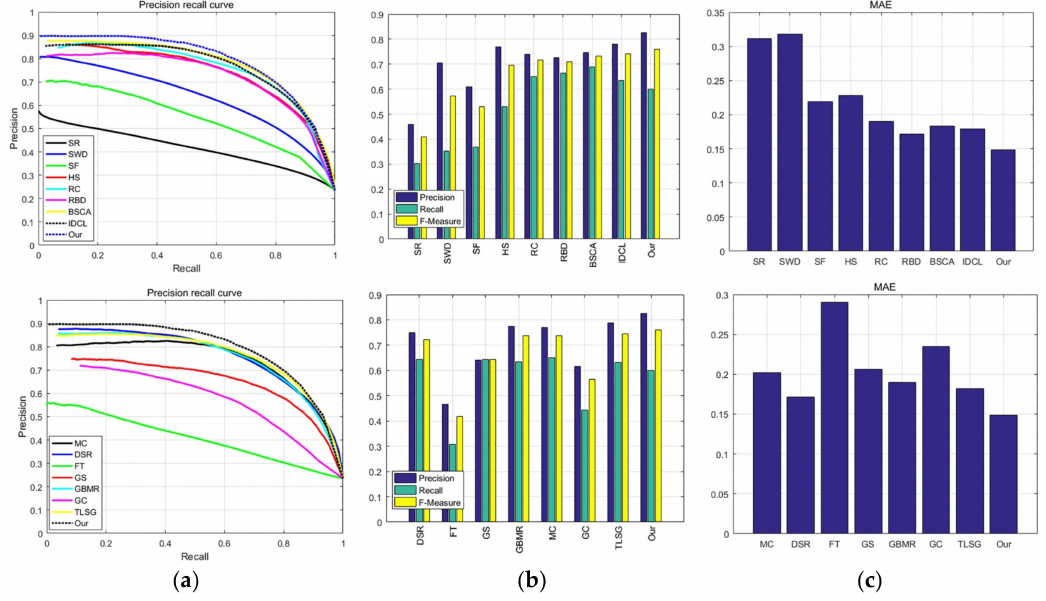
Figure 14. The comparison results on the ECSSD dataset. ( a ) Precision-recall curves. ( b ) Precision, recall, and F-measure at adaptive threshold. ( c )